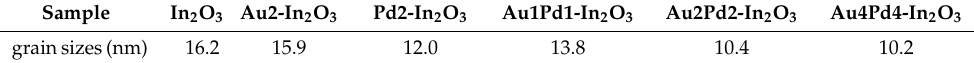
Table 1. Grain size of all samples.